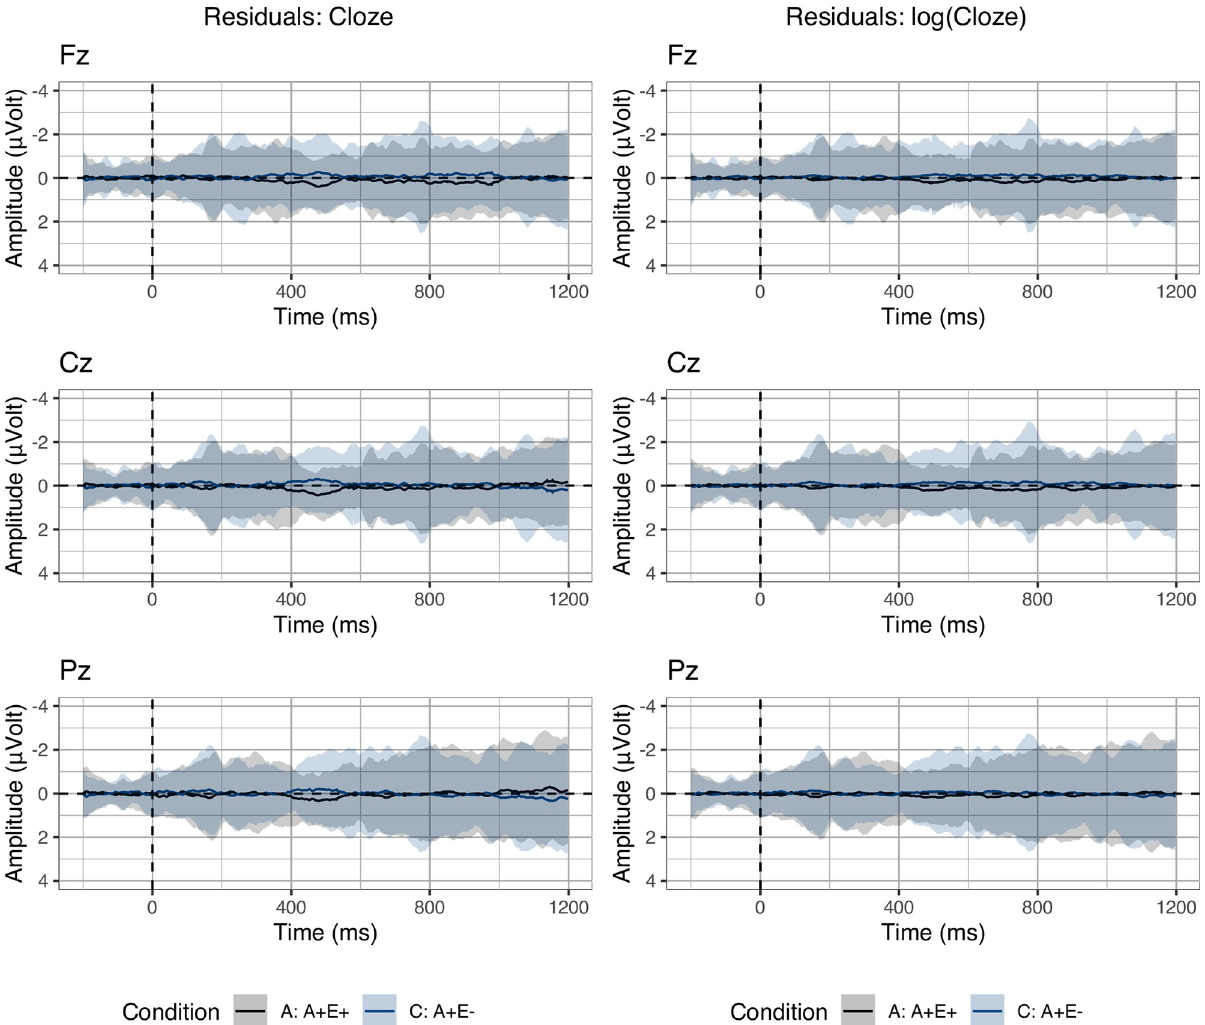
Fig 3. Residual error: Cloze. Residual error between observed voltages and estimated voltages in Conditions A and C using raw Cloze (left) or log (Cloze) (right) as predictor. Larger deviations from zero indicate larger model error. Ribbons indicate standard error computed from the per-subject per-condition